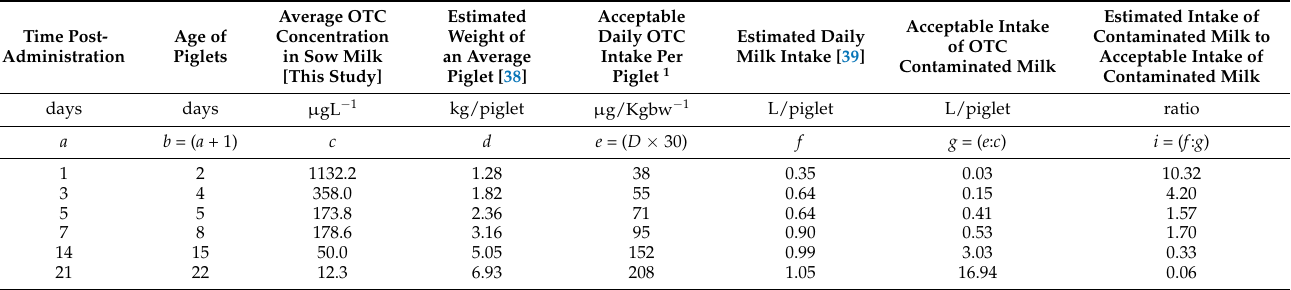
Table 4. Estimated exposure of suckling piglets to oxytetracycline (OTC) ingested with contaminated sow milk after a single intramuscular administration of a long-acting form of the drug given to sows at a single dose of 30 mg per kg of body